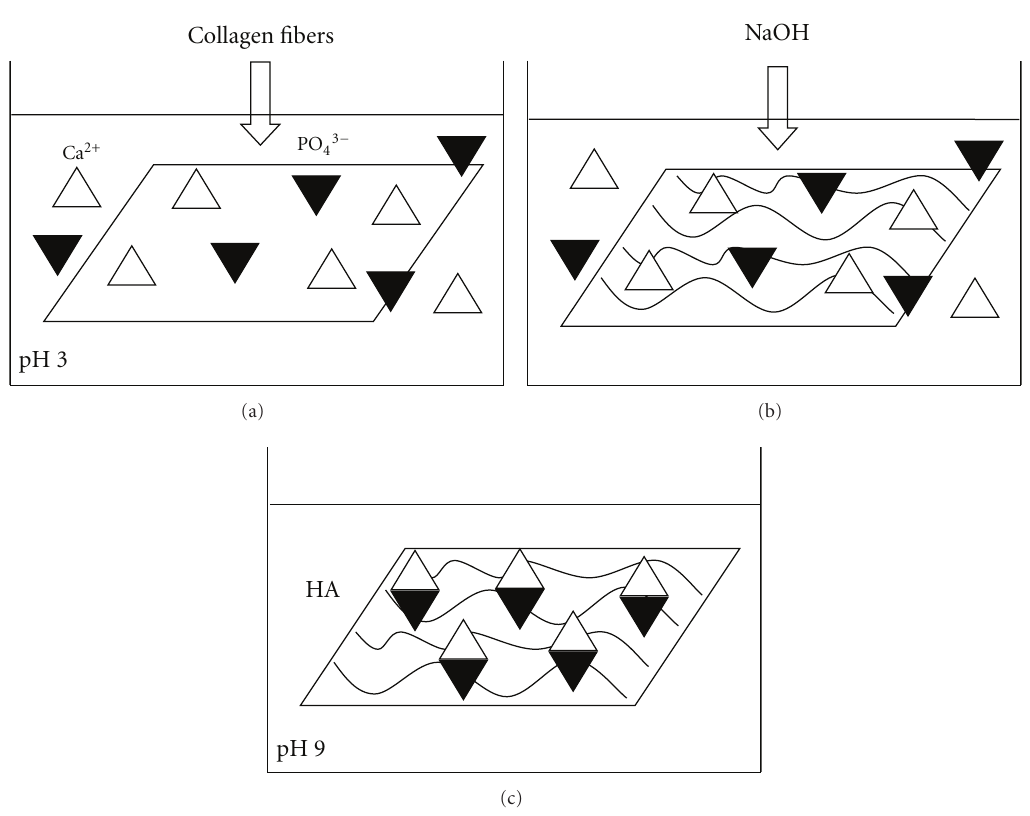
Figure 1: Scheme of the processing steps involved in the electrospun nanostructured collagen-hydroxyapatite fibers preparation: (a) electrospinning of collagen in CH 3 COOH solution into an aqueous calcium and phosphate precursor solutions (Ca(CH 3 COO) 2 and NH 4 H 2 PO 4 , resp.) at pH 3; (b) hydrolysis with NaOH to pH 9; (c) aging the composite in reaction mixture for 15min, followed by harvesting and vacuum